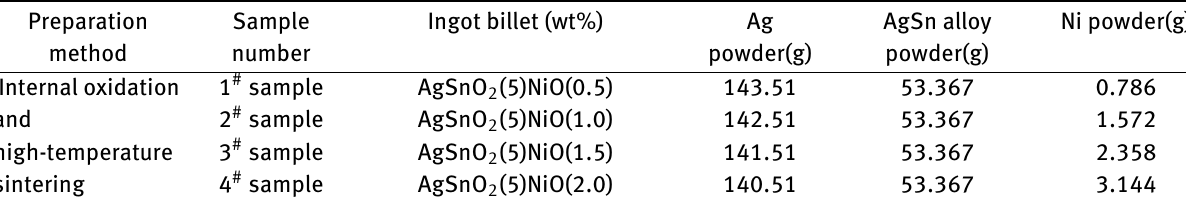
Table 1: The amounts of raw materials to prepare 200g AgSnO 2 NiO ingot Preparation